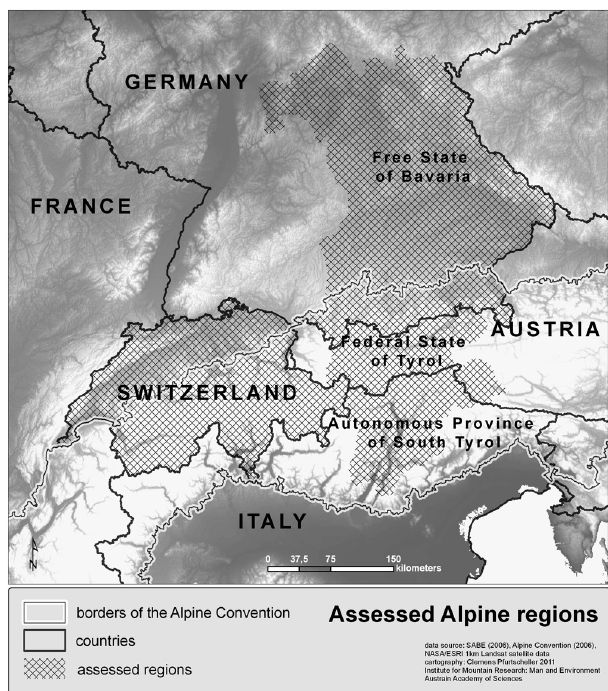
Fig. 1. Assessed Alpine regions: Free State of Bavaria (Germany), Federal State of Tyrol, (Austria), Autonomous Province of South Tyrol (Italy) and